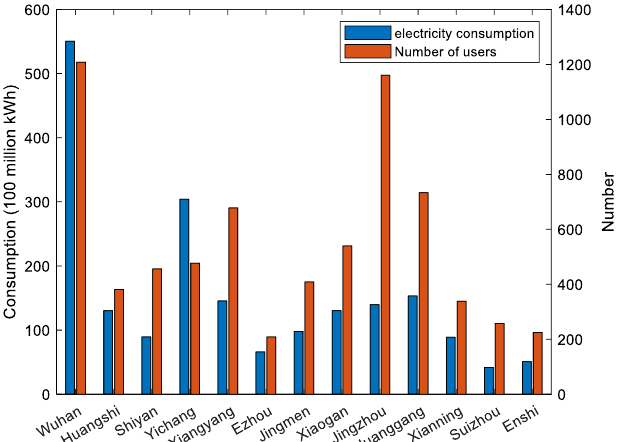
Figure 2. Statistics of electricity consumption and the number of power users in various cities in Hubei Province.